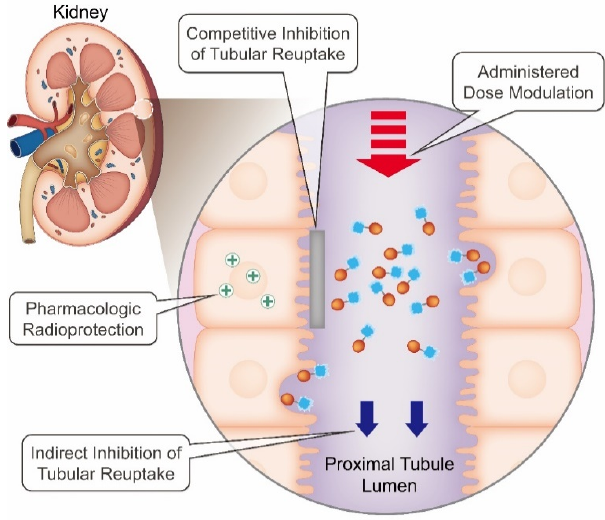
Figure 1. Strategies to reduce absorbed radiation dose to the kidneys.